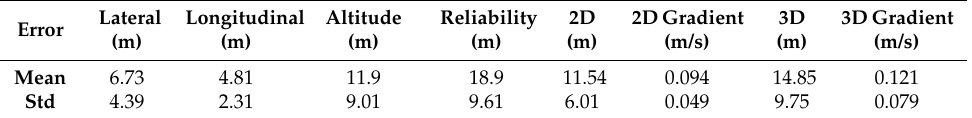
Figure 11. Experiment 3: positioning error and reliability estimation result. The top panel represents the positioning error in lateral, longitudinal and altitude directions, respectively. The bottom panel represents the estimated reliability and 3D positioning error of SLAM. Table 4. Experiment 3: Performance of NDT-based graph SLAM in a dense urban area with normal traffic condition.